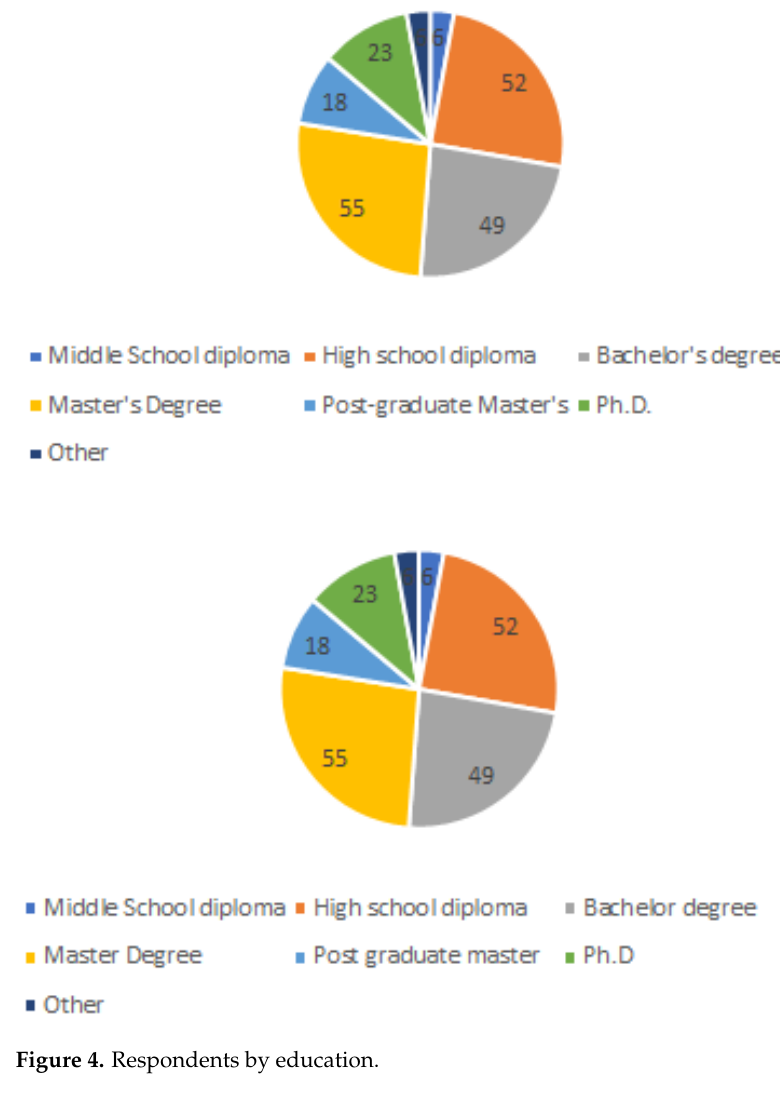
Figure 5. Respondents by working position.